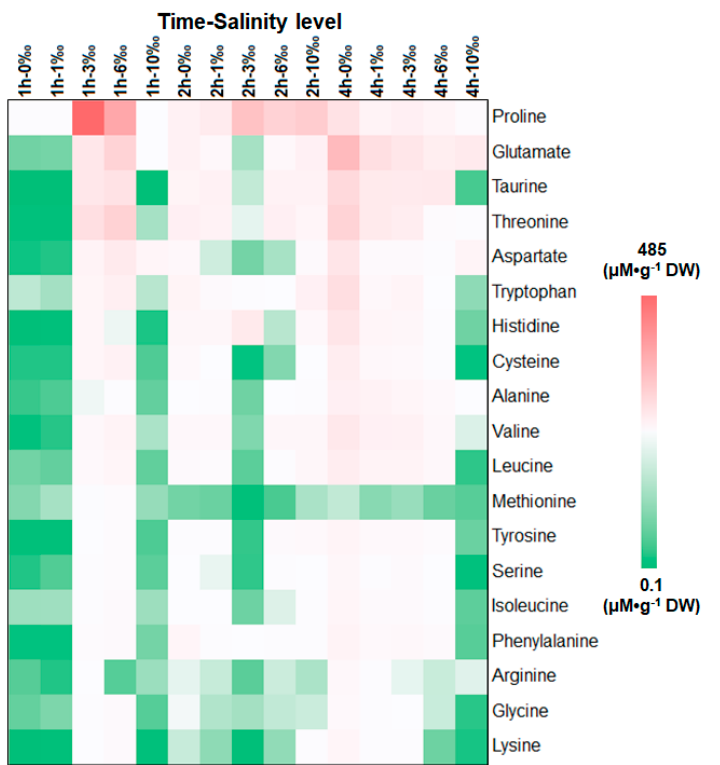
Figure 1. Heatmap of variation of each single amino acid with salinity levels and stress time. The red indicates the higher the concentration, and the green indicates the lower the concentration.